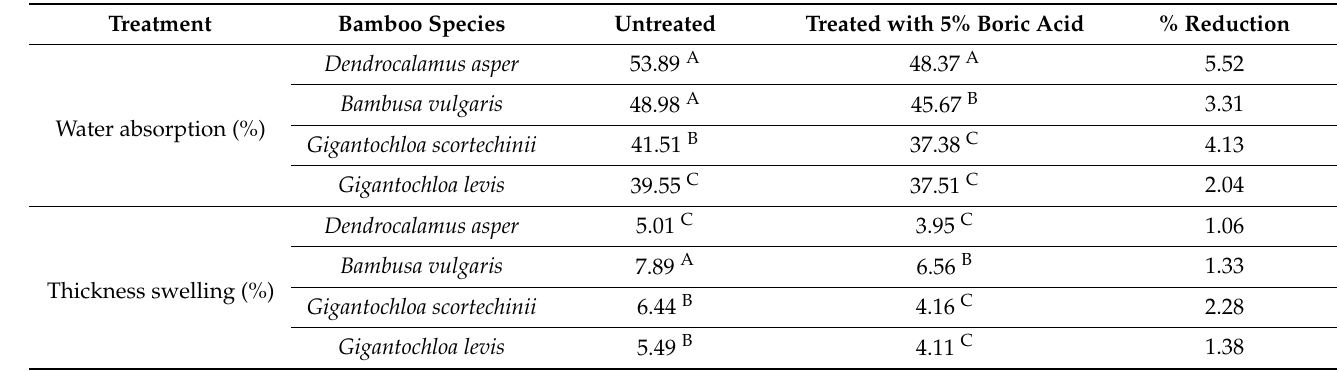
Figure 5. Moisture Excluding Efficiency (MEE) of untreated and treated bamboo strips for four selected species. Note: Bars of mean followed with the same letters A,B,C,D were not significantly different at p ≤ 0.05. Table 5. Water absorption and thickness swelling of untreated and treated bamboo strips for four selected species.